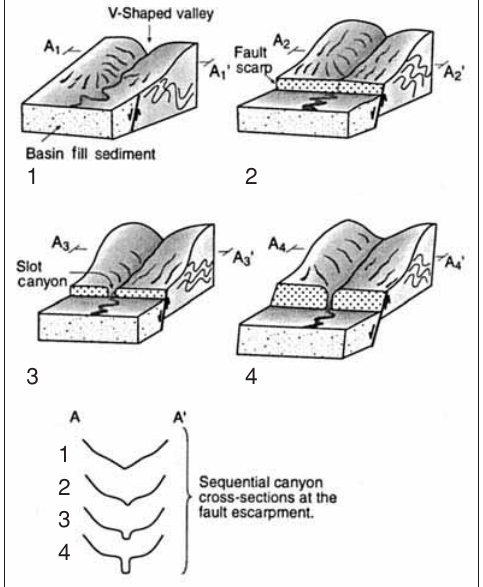
Fig. 8. Formation of a wineglass canyon. From Wood- ward-Clyde Federal Services (1996). 1 - Tributary drai- nage crosses normal faulted basin margin at grade. 2 - Normal faulting event. Tributary drainage offset ver- tically. 3 - Drainage erodes down to new base level. 4 - Repeated fault movement. Scarp height increases, as does depth of slot canyon if rate of faulting is greater than